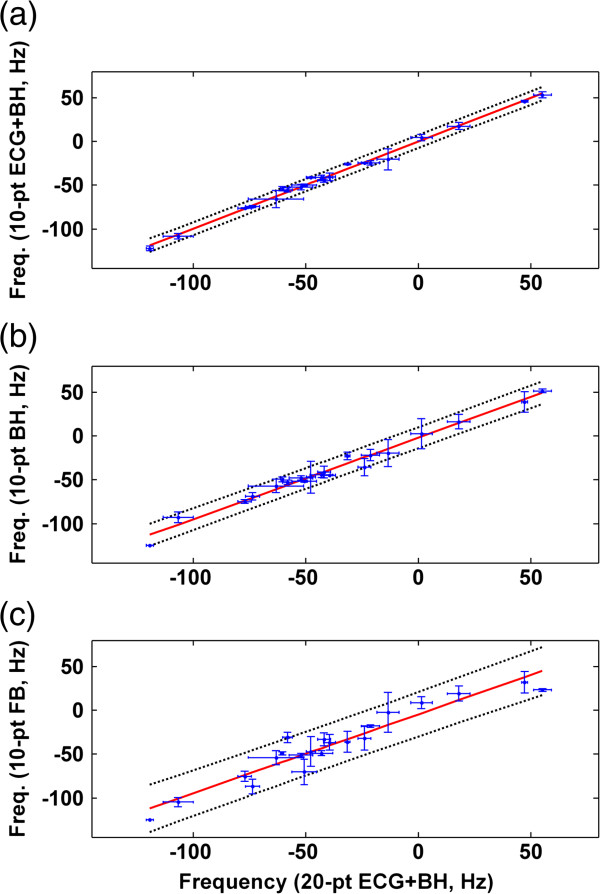
Group analysis of 10-pt sweep scan datasets against 20-pt BH + ECG datasets (a) 10-pt BH + ECG vs. 20-pt BH + ECG, (b) 10-pt BH vs. 20-pt BH + ECG, (c) 10-pt FB vs. 20-pt BH + ECG (blue dot and error bar: mean and standard deviation of the Δf values obtained in three repeated scans, red line: linearly fitted lines, black dotted line: 95% prediction interval).